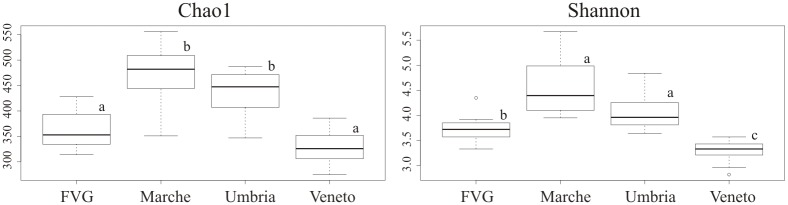
Box plots of Chao1 and Shannon diversity indices estimated for each site.Significant differences among sites were calculated with ANOVA and Duncan’s new multiple range test and are indicated by different letters a-c (p-value < 0.05).